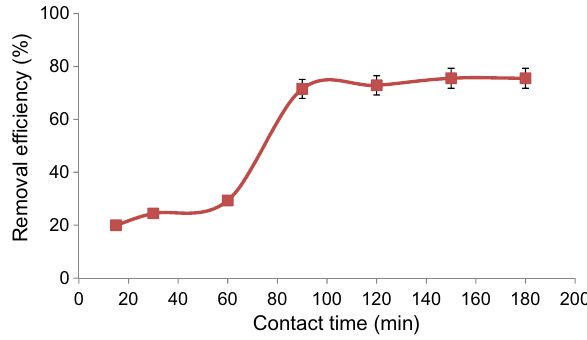
Fig. 1 Effect of contact time on the adsorption of Cd(II) ion onto UMSFS